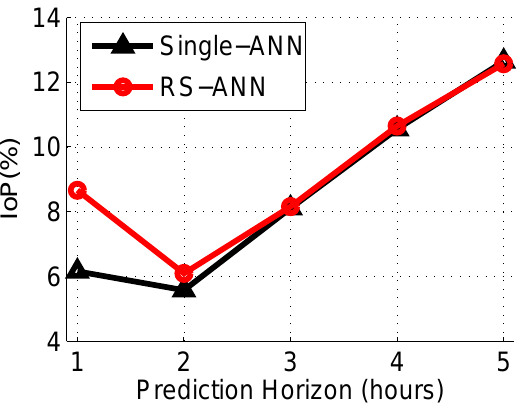
Figure 3. Improvement over Persistence for di ff erent prediction Fig. 3. Improvement over Persistence for different prediction hori- horizons (case for h =